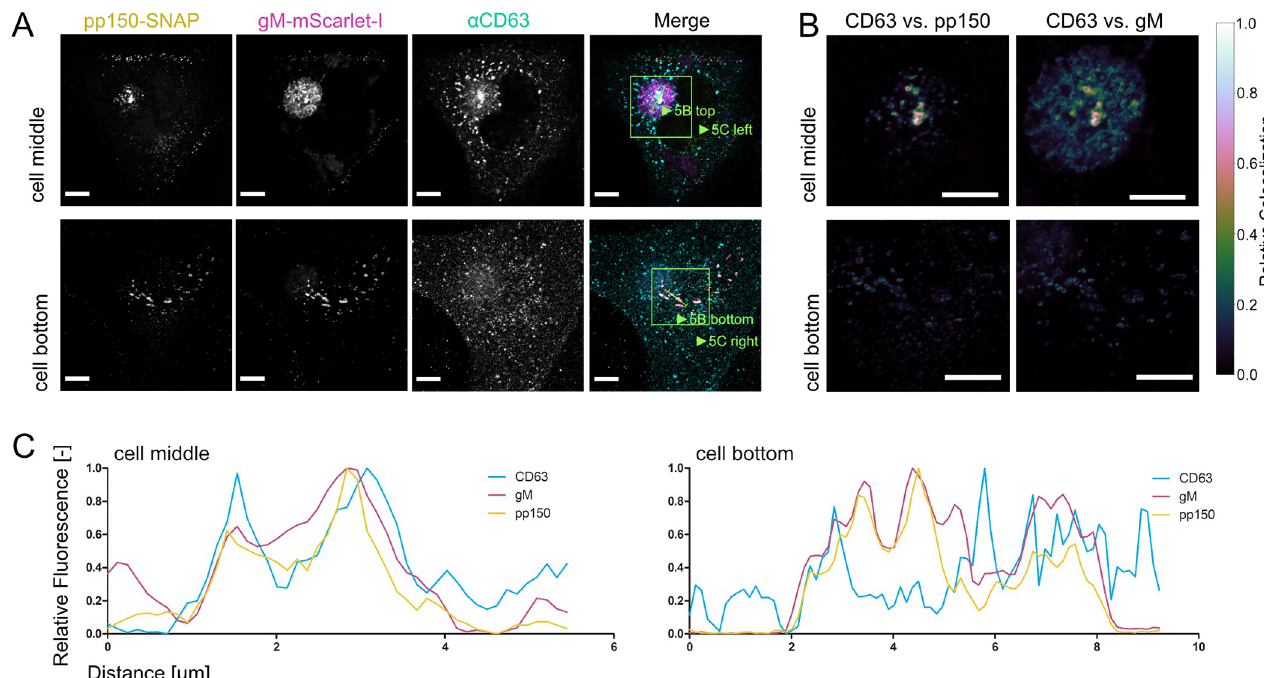
Fig 5. Tetraspanin CD63 localizes to MViBs. 5A HFF cells were infected at an MOI of 1 with HCMV-pp150-SNAP-gM-mScarlet-I, fixed at 4 dpi, stained for CD63, and whole cells were imaged using confocal laser scanning microscopy. From a representative cell, two slices are shown. One slice depicts the middle of the cell (cell middle), and one depicts the plasma membrane level (cell bottom). The fluorescence pattern of CD63 ( α CD63) was compared to gM (gM- mScarlet-I), and pp150 (pp150-SNAP). In the cell’s center, CD63 localized to the assembly complex’ center and marked MViBs in the cytoplasm, which were pp150 and gM positive. At the plasma membrane, EVAs were positive for pp150 and gM signals but lacked CD63. 5B Spatially weighted colocalization analysis shows areas in the assembly complex where CD63 colocalization with MViBs is especially pronounced (cell middle). No significant colocalization between CD63 and pp150 or gM is present in EVAs (cell bottom). All scale bars (5A and 5B) indicate 10 μ m. 5C Line plots for the indicated areas in 5B.